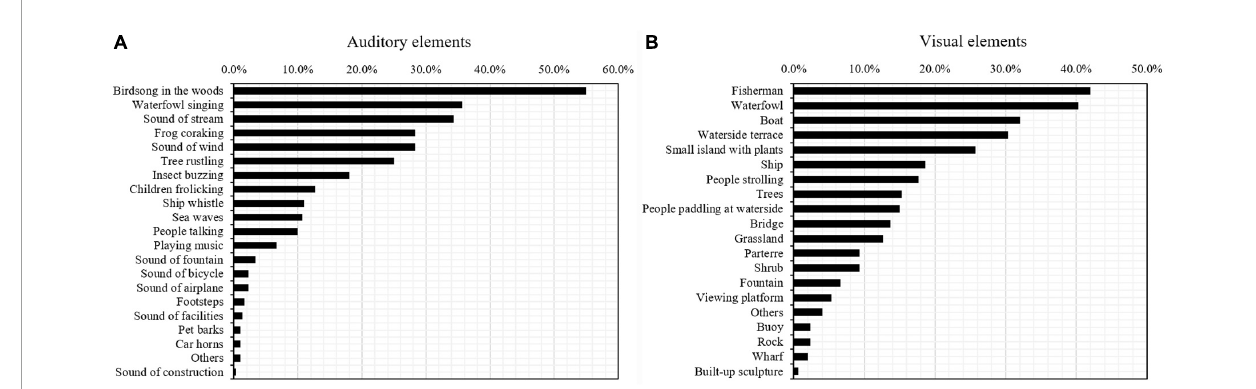
FIGURE6 Percentage of auditory elements (A) and visual elements (B) possessing restorative potential in urban waterfront spaces.